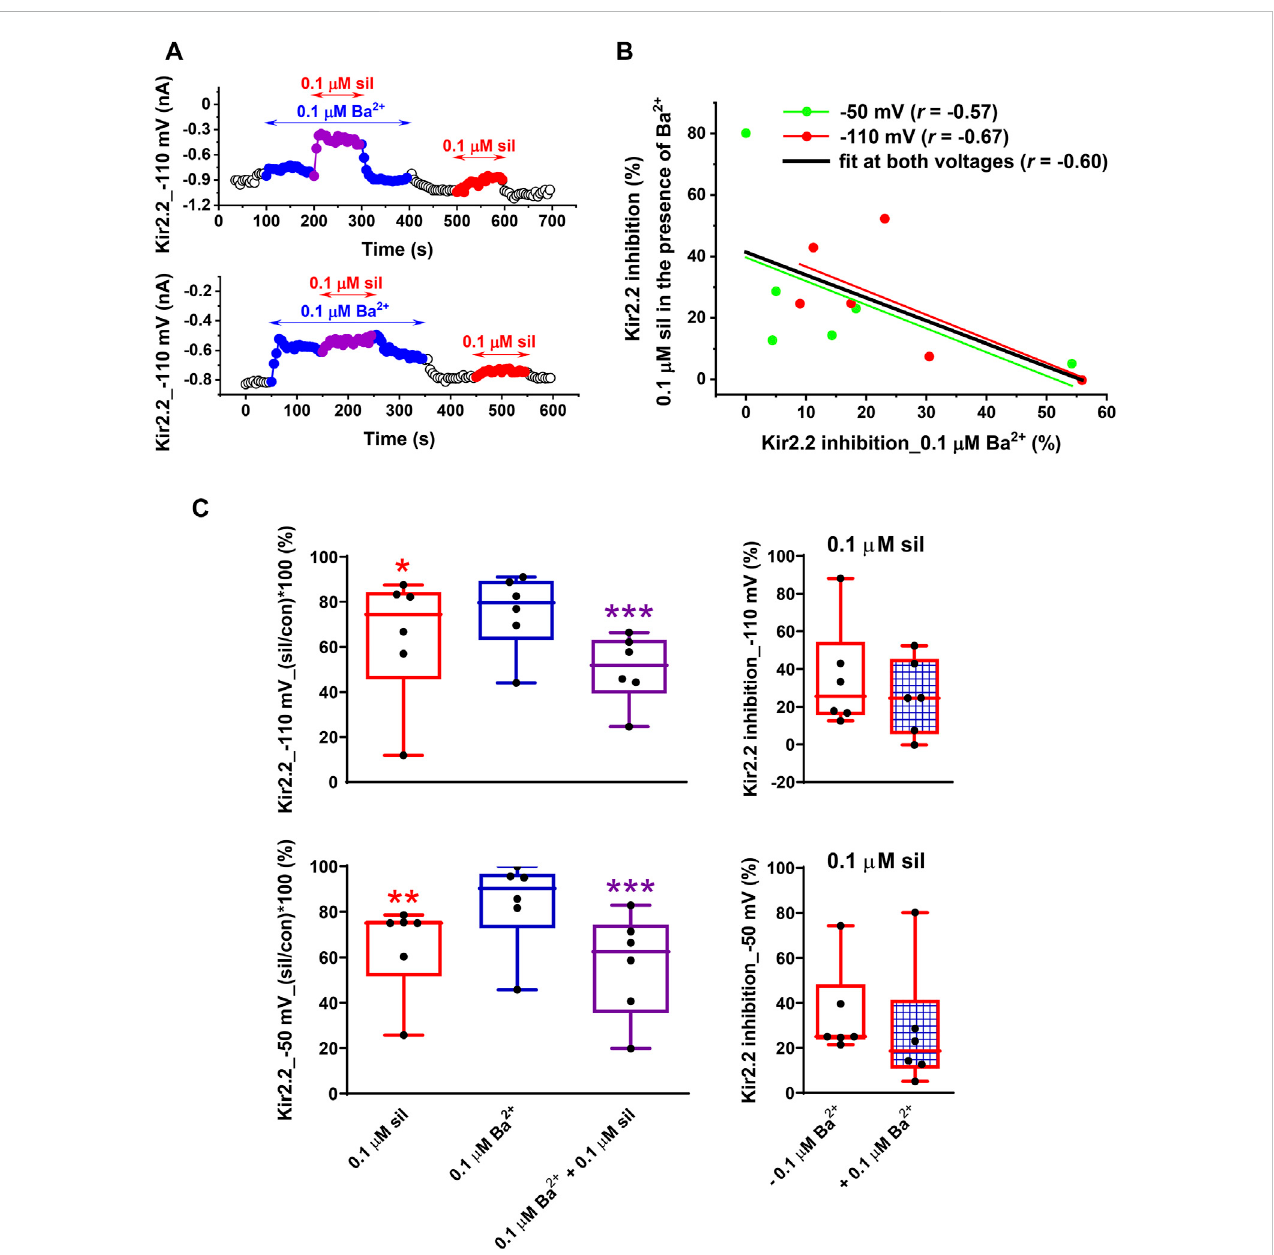
Impact of a low concentration of Ba 2+ on the effect of sildena fi l on the human Kir2.2 channels. (A) Kir2.2 changes at − 110 mV during the application of 0.1 µMsildena fi l(sil)intheabsenceandpresenceof0.1 µMBa 2+ intworepresentativecells. (B) ThehigherwastheinhibitionofKir2.2by0.1 µMBa 2+ ,thelower was the effect of 0.1 µM sildena fi l in the presence of 0.1 µM Ba 2+ ( i.e., the less likely potentiation of the sildena fi l effect was apparent; if both voltages were takenintoaccount, thePearson´scorrelationcoef fi cient r = − .60, p < 0.05). (C) Incontrastto Kir2.1channels(Figure 4B,rightpanel),theeffectof0.1 µM sildena fi ldidnotdifferintheabsenceandpresenceof0.1Ba 2+ onaverage,bothat − 110andat − 50 mV( n =6);*,**,and*** — statisticalsigni fi canceat p < 0.05, 0.01, and 0.001,